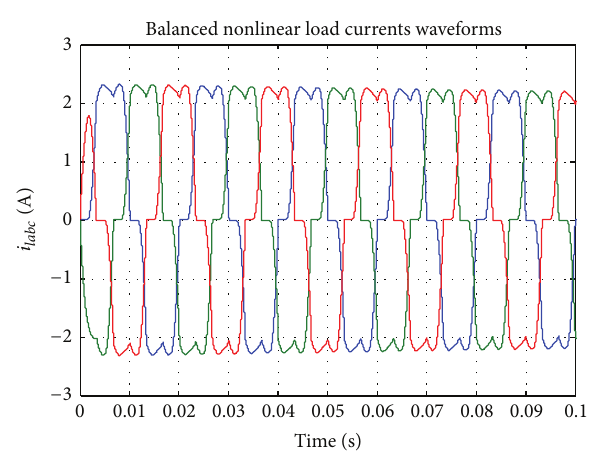
Figure 7: Balanced nonlinear load currents waveforms.